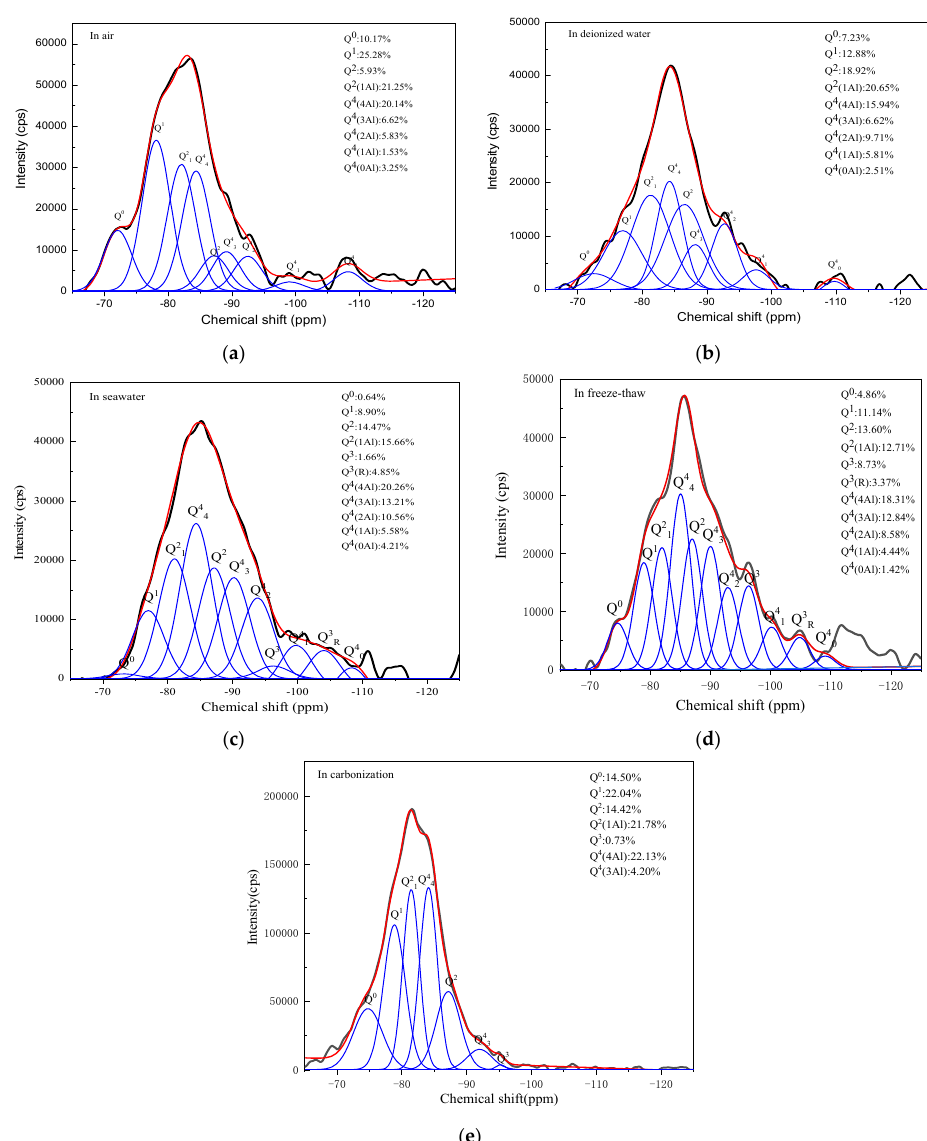
Figure 6. The deconvolution of 29 Si NMR spectra of geopolymers prepared with 60% BFS subjected to different